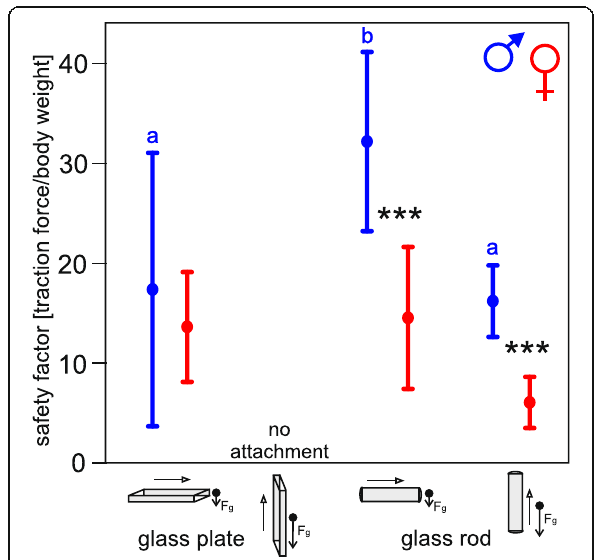
Fig. 4 Safety factors generated by male and female Monochamus alternatus on a glass plate and glass rod; scatterplot showing column means and standard deviations. Attachment failed on vertically oriented, flat glass. Arrows with unfilled heads point to the direction of traction, and arrows with filled heads point to the direction of acting gravity. Dots show means with standard deviations ( lines ). The asterisks mark statistical differences between males ( blue ) and females ( red ) on horizontal flat glass: Mann-Whitney test, T = 26, p = 0.841, on horizontal glass rod: t -Test, t = − 3.5, p = 0.009, and on vertical glass rod: t -Test, t = − 4.6, P = 0.002; different letters indicate statistical differences between substrates in males (one-way ANOVA, F 2,13 = 4.2, P = 0.04, Fisher LSD method). Values not differ significantly between substrates in females (one-way ANOVA, F 2,13 = 3.7, P =